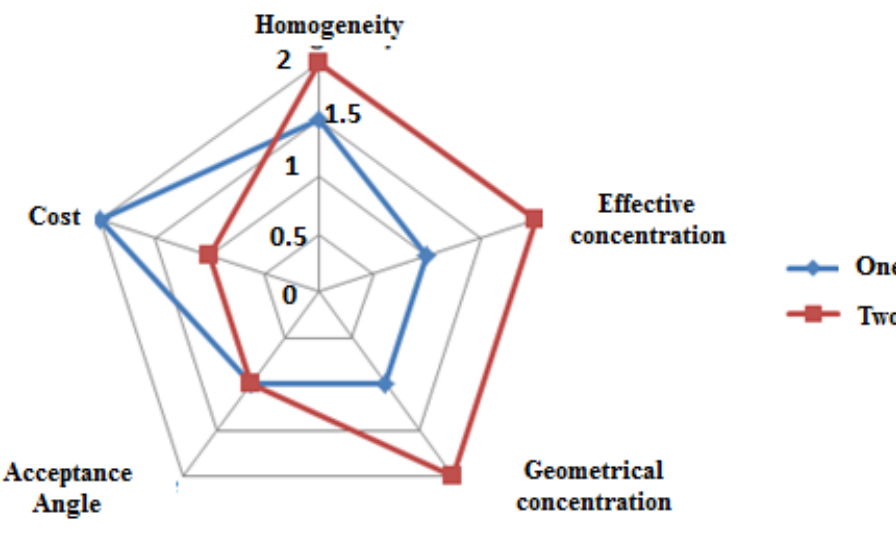
Figure 42. Advantages and disadvantages of optical